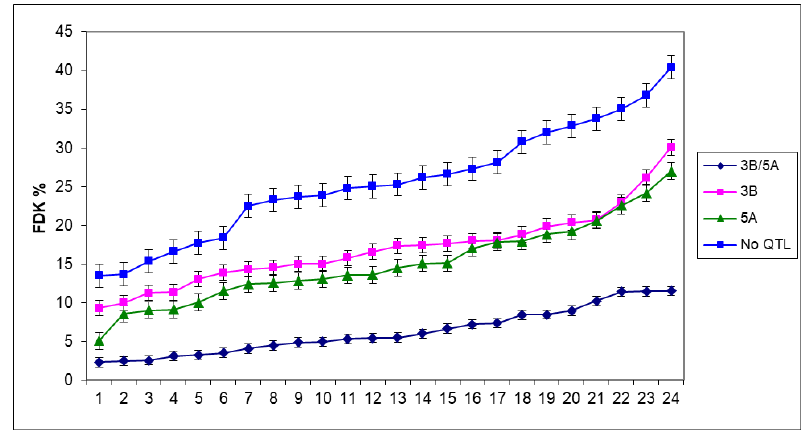
Figure 7. FDK values (percentage) in the CM82036/Remus population across years, locations, and isolates, 2002–2003. LSD 5% for genotypes 3.37, for QTL groups 0.67 [53]. Table 2. ANOVA of the FDK data of the CM82036 / Remus population. Source of